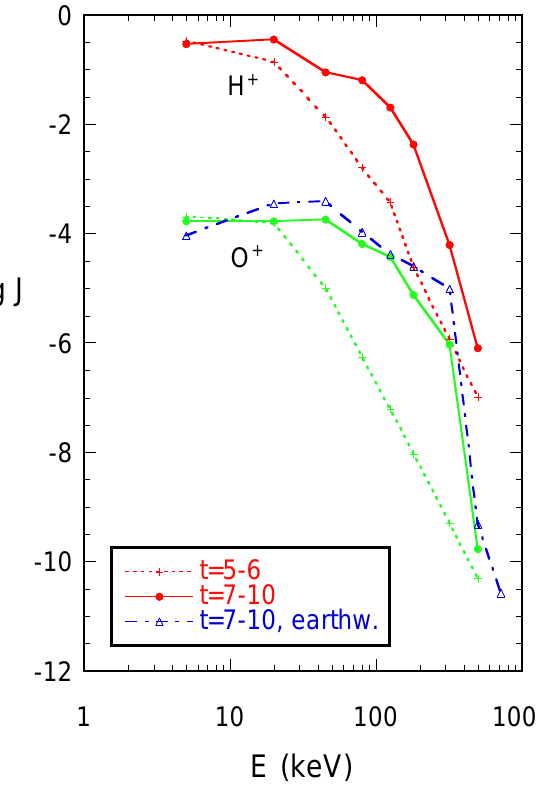
Fig. 9. O + fluxes as a function of energy at x =− 10 ,y = 3 ,z = 0. The fluxes are calculated using initial kappa distributions (see text) and are averaged over 14 different directions. The dash-dotted line represents earthward O + flux